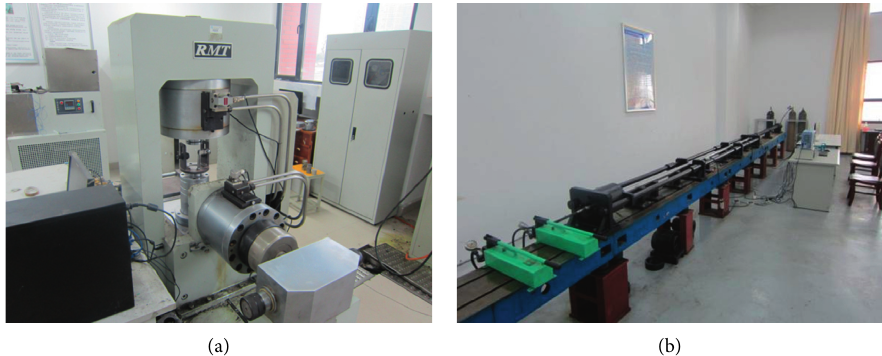
Figure 8: Static and dynamic test devices. (a) RMT-150B. (b) SHPB system.